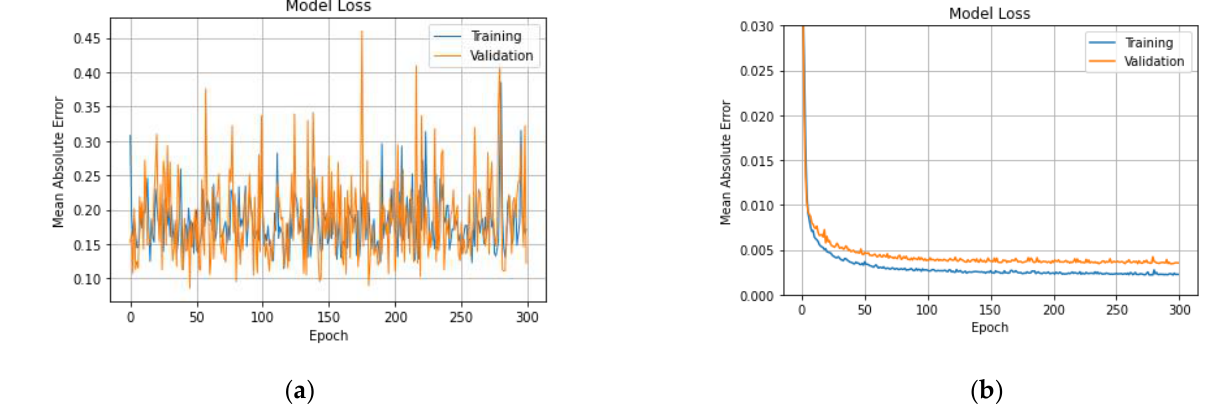
Figure 2. MAE for AOD prediction in ( a ) linear regression and ( b ) DNN.